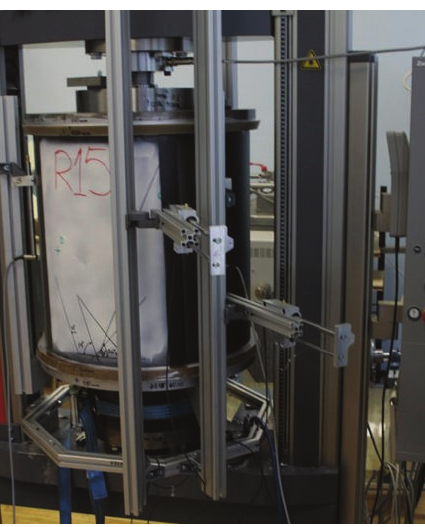
Figure 4: Experimental test setup for compressive loading on R15 and SST-1 cylindrical shells (RTU).